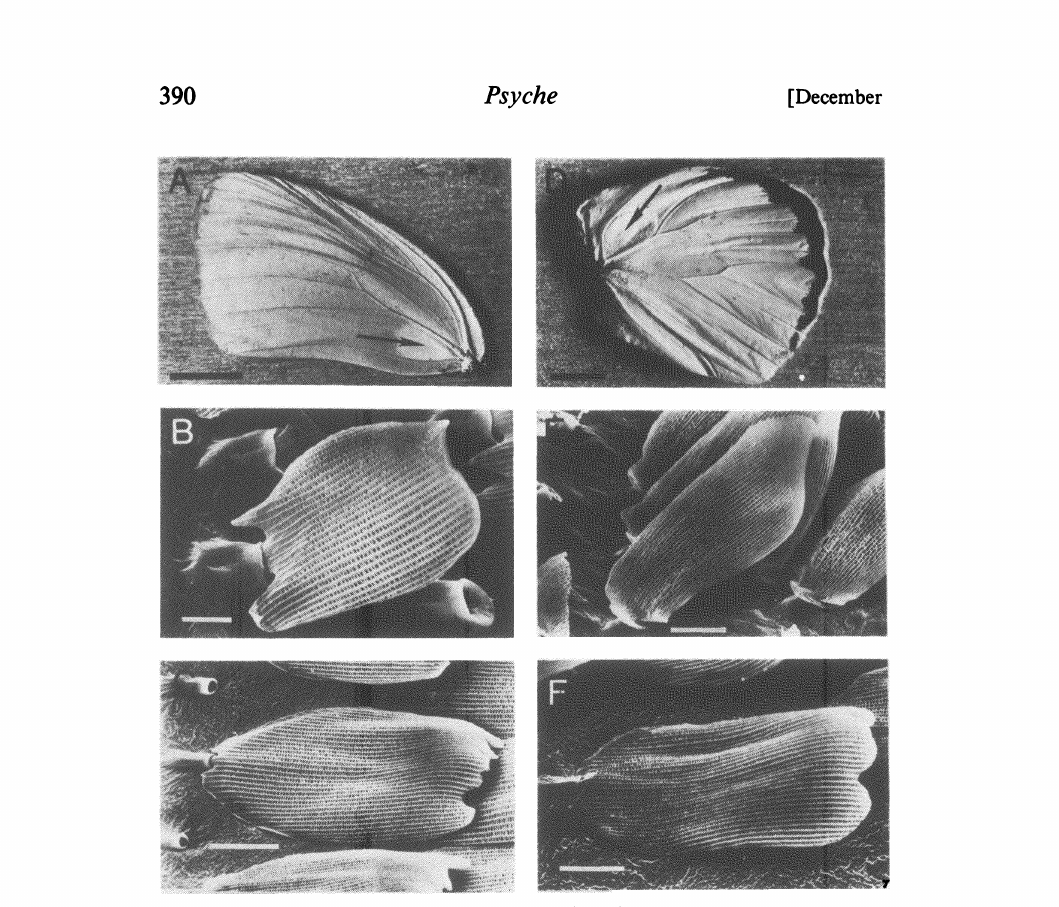
Figure 3. Eurema nicippe: A, male ventral forewing (note sex brand under tip of arrow); scanning electron micrographs of male scales from the sex brand (B) and the discal cell (C). Colias cesonia: D, male dorsal hindwing (note sex brand under tip of arrow); scanning electron micrographs of male scales from the sex brand (E) and the distal cell (F). Scale lines: A and C, 5mm; B, 10#; C and F, 20#; E,